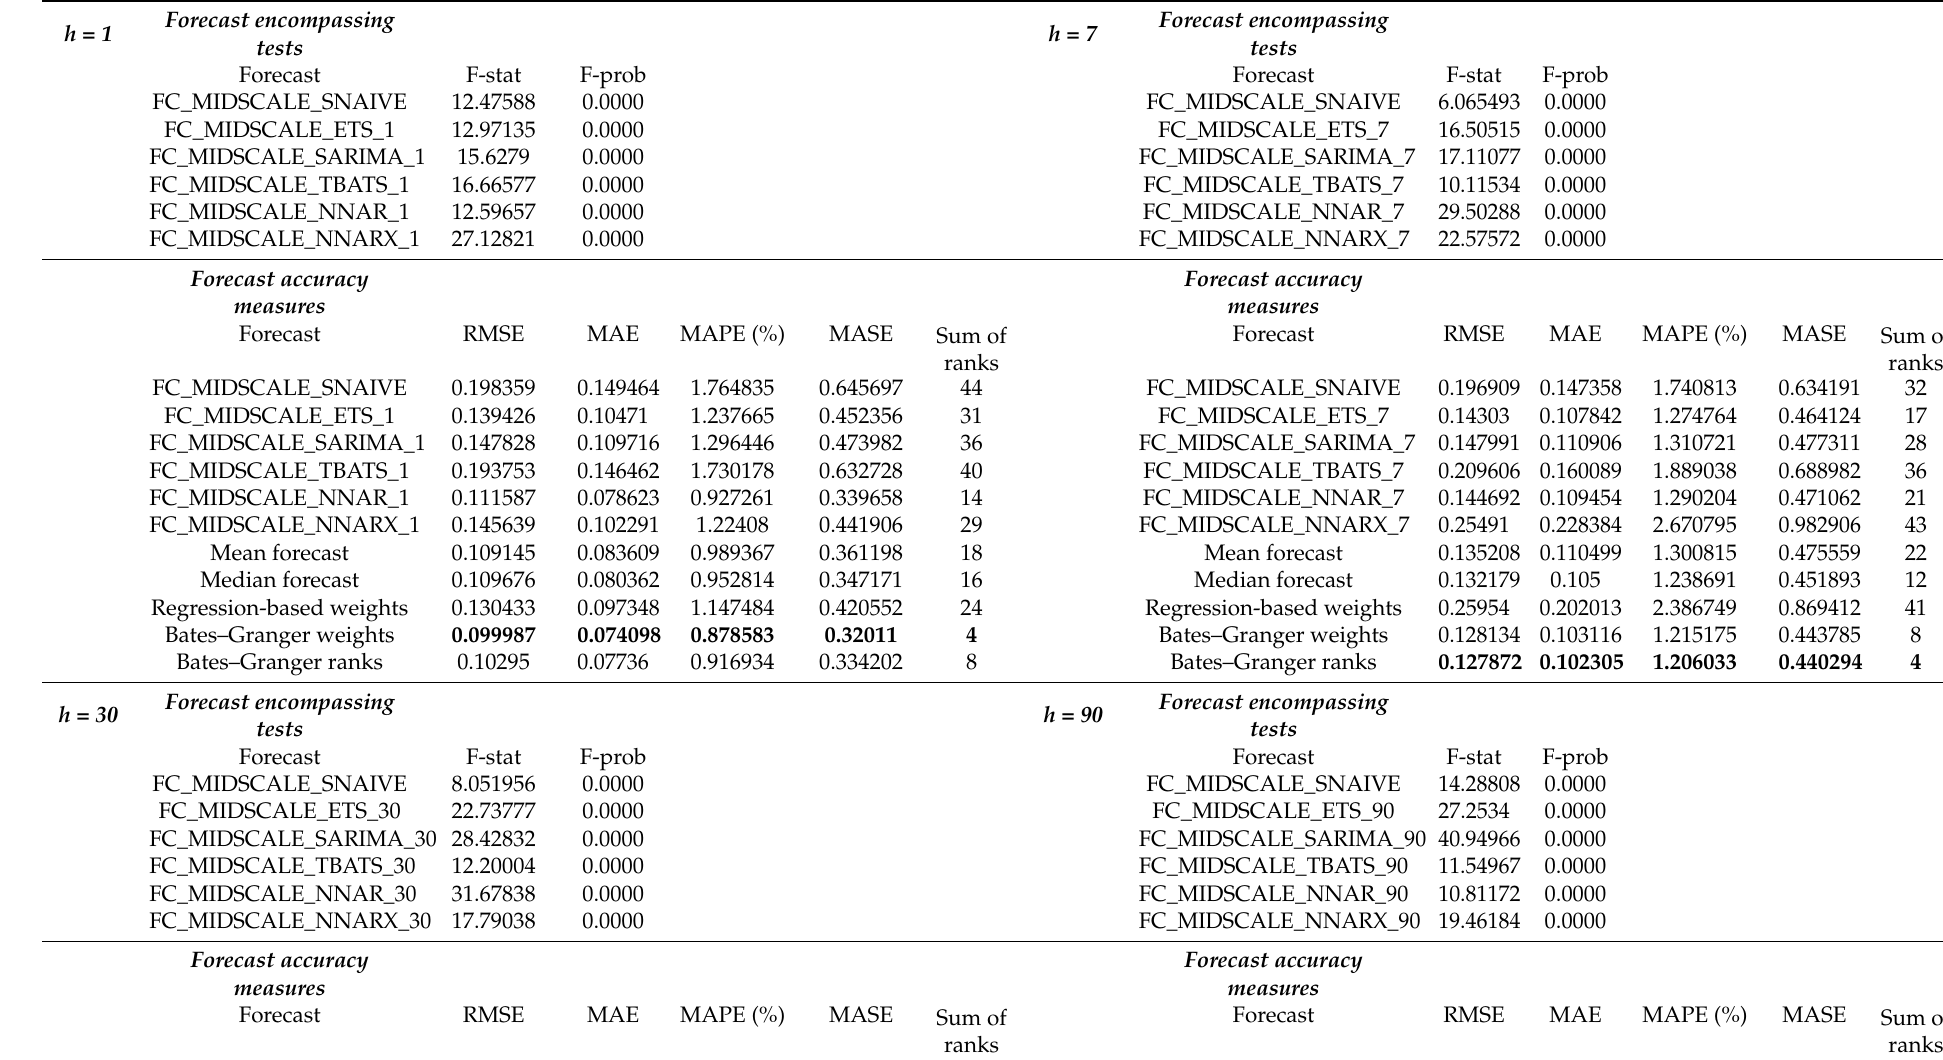
Table A5. Forecast evaluation results for the hotel class ‘midscale’. Source: STR SHARE Center, own calculations using R and